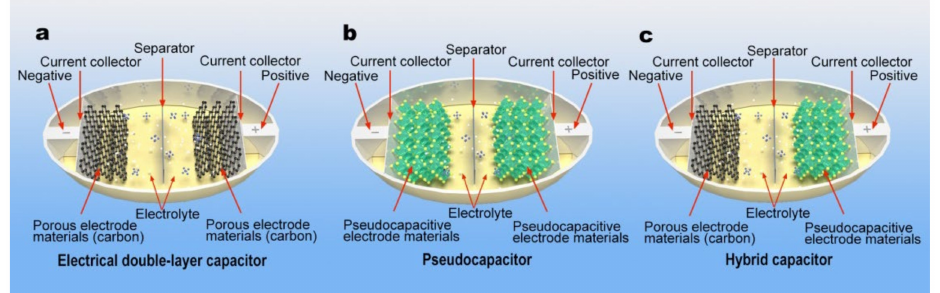
Figure 3. Schematic illustrations of ( a ) a EDLC with porous carbon materials for each electrode, ( b ) a pseudocapacitor with transition metal-related material for each electrode, and ( c ) asymmetric hybrid capacitors utilizing a porous carbon negative electrode and a transition metal oxide positive